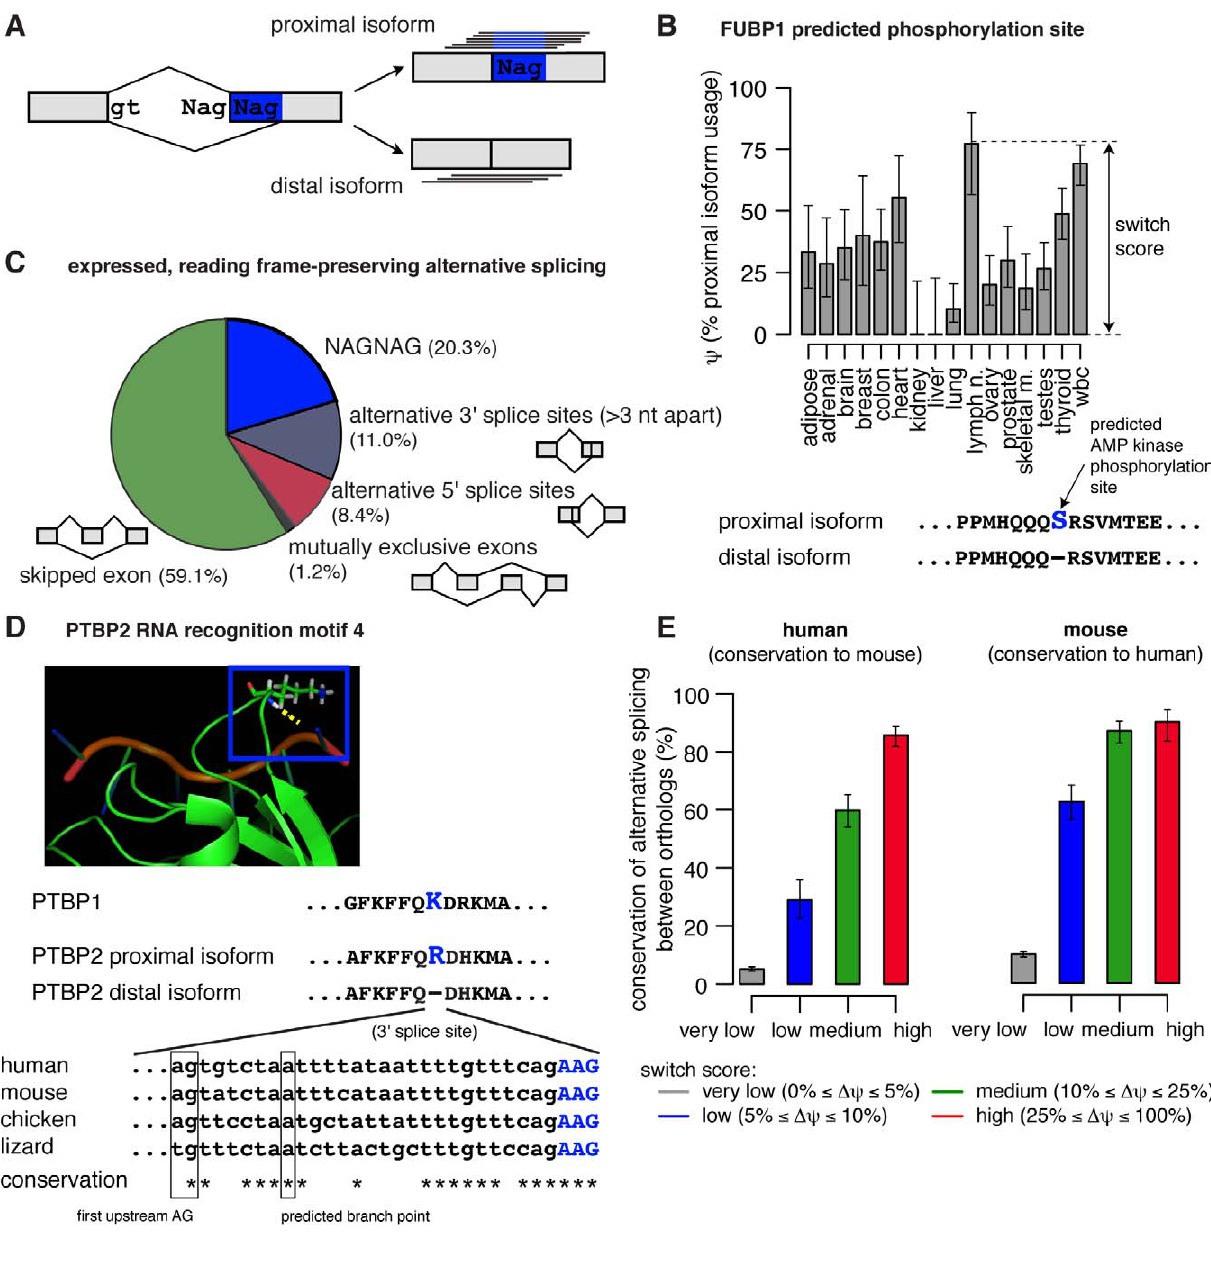
Figure 1. Alternative splicing of tissue-specific NAGNAGs is highly conserved. (A) Short reads were aligned to the intron-proximal and intron-distal splice junctions of NAGNAG splicing events in order to estimate isoform ratios. (B) Estimated proximal isoform usage ( y ) for a NAGNAG which inserts/deletes a predicted phosphorylation site in far upstream element binding protein 1 (FUBP1). Phosphorylation site and corresponding kinase were predicted by Scansite (Scansite z -score 2 3.024) [55]. Error bars indicate the 95% binomial confidence interval. (C) Number of reading frame-preserving alternative splicing events in protein-coding regions, with both isoforms expressed at $ 5% in at least one tissue (see also Table S1). (D) A NAGNAG which inserts/deletes an arginine in RNA recognition motif 4 (RRM4) of the splicing factor PTBP2 is deeply conserved. Alignment of orthologous 3 9 splice site sequences shown below the NMR structure (PDB accession 2ADC, displayed with PyMOL) of the highly homologous PTBP1 protein (green) complexed with RNA (red) [33]. Boxed is K489 of PTBP1, which is homologous to the arginine shown in PTBP2, and hydrogen bonds to the RNA backbone (dotted yellow line). Putative branch point based on location of the first upstream AG, the sequence motif identified in [56], and the pattern of sequence conservation. (E) Conservation of alternative splicing between orthologous human and mouse NAGNAGs increases with tissue specificity. NAGNAGs that were alternatively spliced in human (left) and mouse (right) were grouped by switch score—defined as the maximum y difference between tissues—as indicated by colors, and the fraction of orthologs which were alternatively spliced in the other species is shown. Error bars indicate 95% binomial confidence intervals.